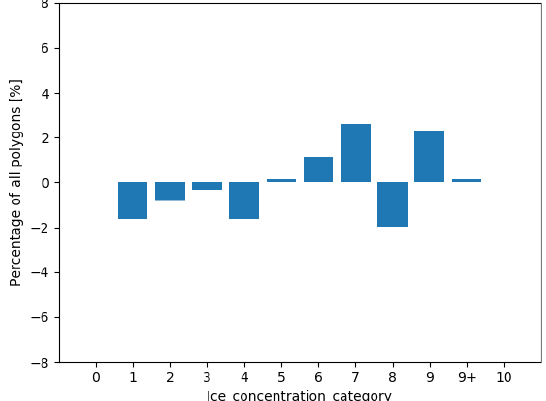
Figure 17. The difference in the distribution of polygons across ice concentration categories for all polygons (visually estimated ice concentration minus the modal ice concentration estimate). The ver- tical axis shows the change in the proportion of polygons. The hor- izontal axis shows the ice concentration category.